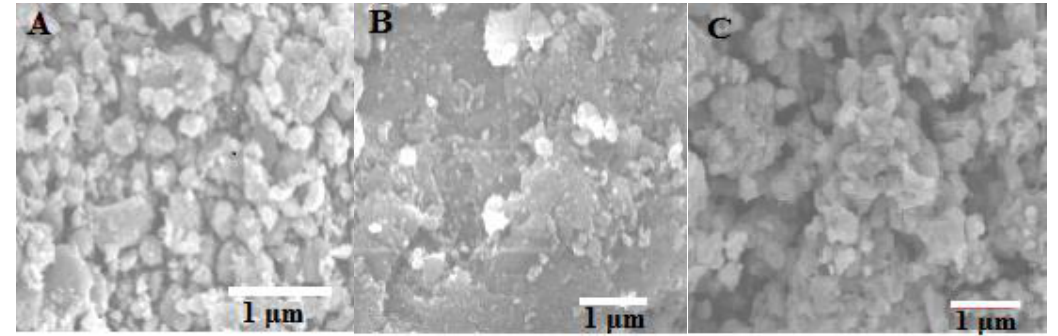
Figure 2. SEM images of ( A ) TiO 2 , ( B ) TC, and ( C ) PPTC.